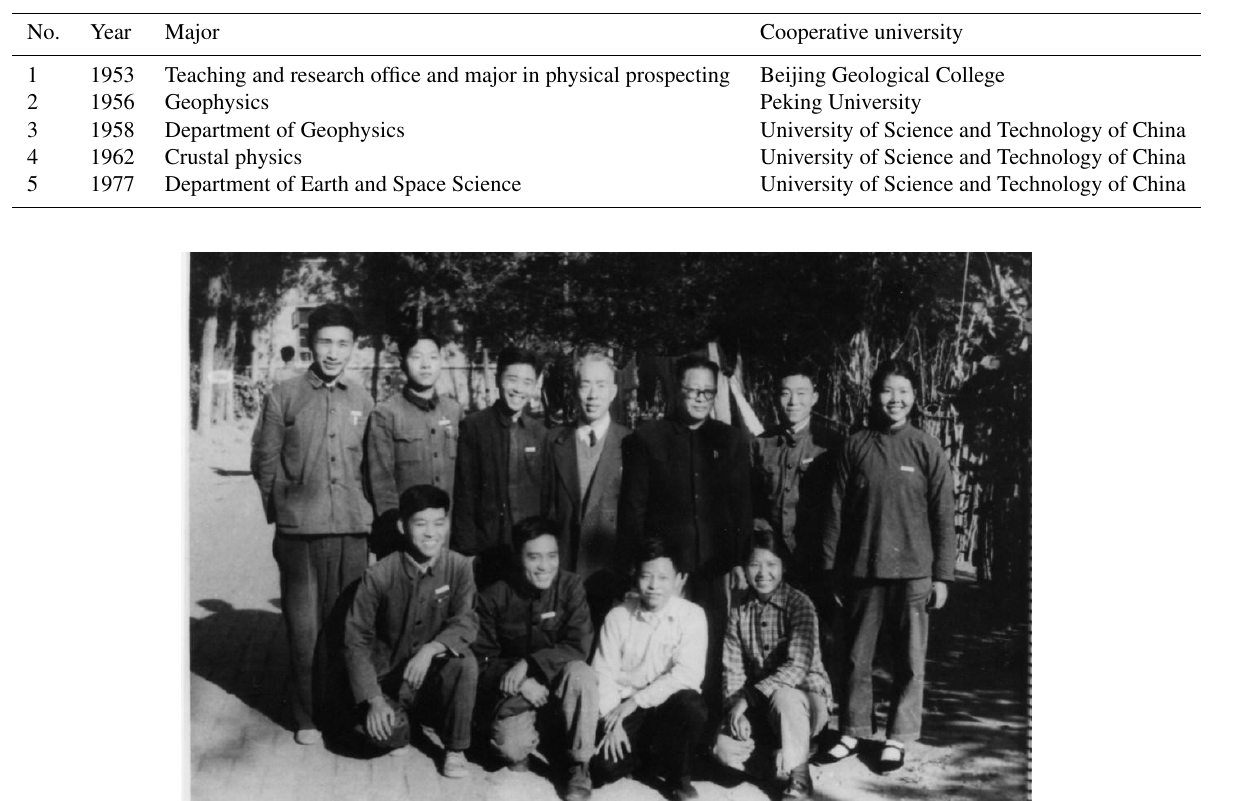
Figure 4. In 1964, Jeou-jang Jaw and Ganchang Wang took a group photo with the first geophysics graduates at the University of Science and Technology of China. Source: courtesy of the China University of Science and Technology